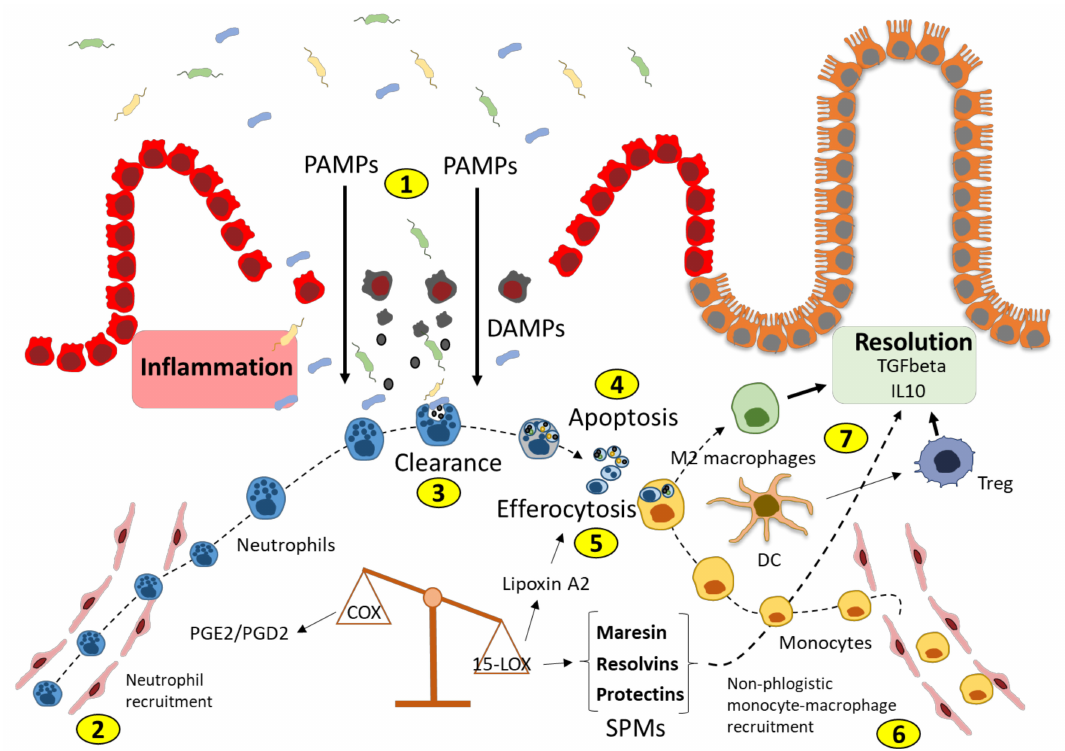
Figure 1. The pro-resolving roadmap. In the presence of pathogen-associated molecular patterns (PAMPs) and / or damage-associated molecular patterns (DAMPs), (1) the cyclooxygenase (COX)-mediated production of prostaglandin (PG) E2 and D2 recruits neutrophils (2) responsible for the clearance of pathogens and cellular debris (3). In a pro-resolving setting, after engulfment, neutrophils undergo apoptosis (4) which promotes efferocytosis (5) by non-phlogistic monocyte–macrophages recruited by 15-lipoxigenase (15-LOX)-generated specialized pro-resolving mediators (SPMs) (6). Efferocytosis in macrophages and dendritic cells (DCs) induces a pro-resolving response characterized by the differentiation of anti-inflammatory M2 macrophages and suppressive regulatory T cells (Tregs)